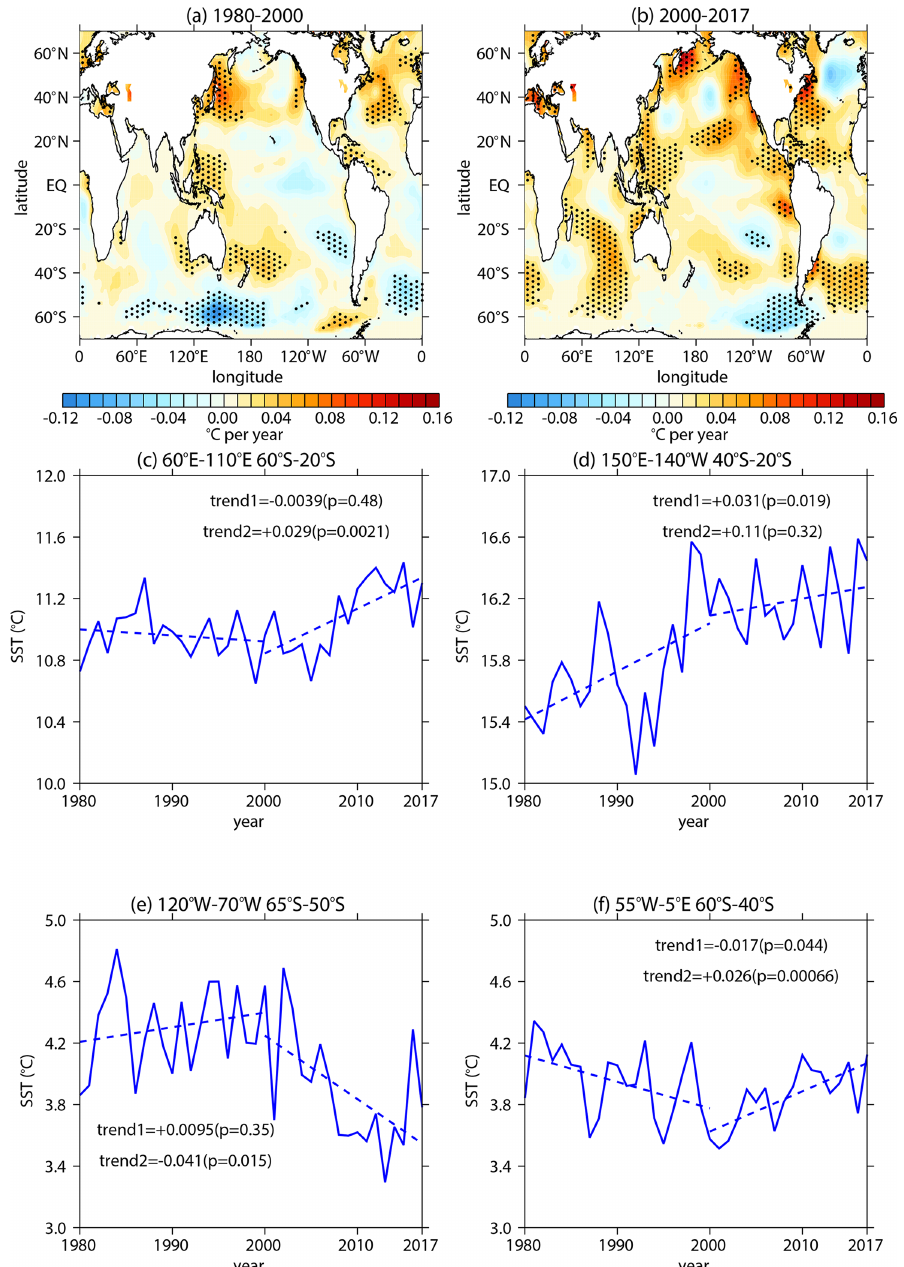
Figure 8. Trends of SST in September over (a) 1980–2000 and (b) 2000–2017 as derived from the ERSST v5 dataset. The stippled regions represent the trends significant at/above the 90% confidence level. (c–f) Time series (blue solid lines) of SST during 1980–2017 over different regions (titles). The dashed lines represent linear regressions of the SST time series on piecewise periods (1980–2000 and 2000–2017). The labels of trend1 and trend2 in panels (c) – (f) represent the trend coefficients and the corresponding significances (in parentheses) over 1980– 2000 and 2000–2017,